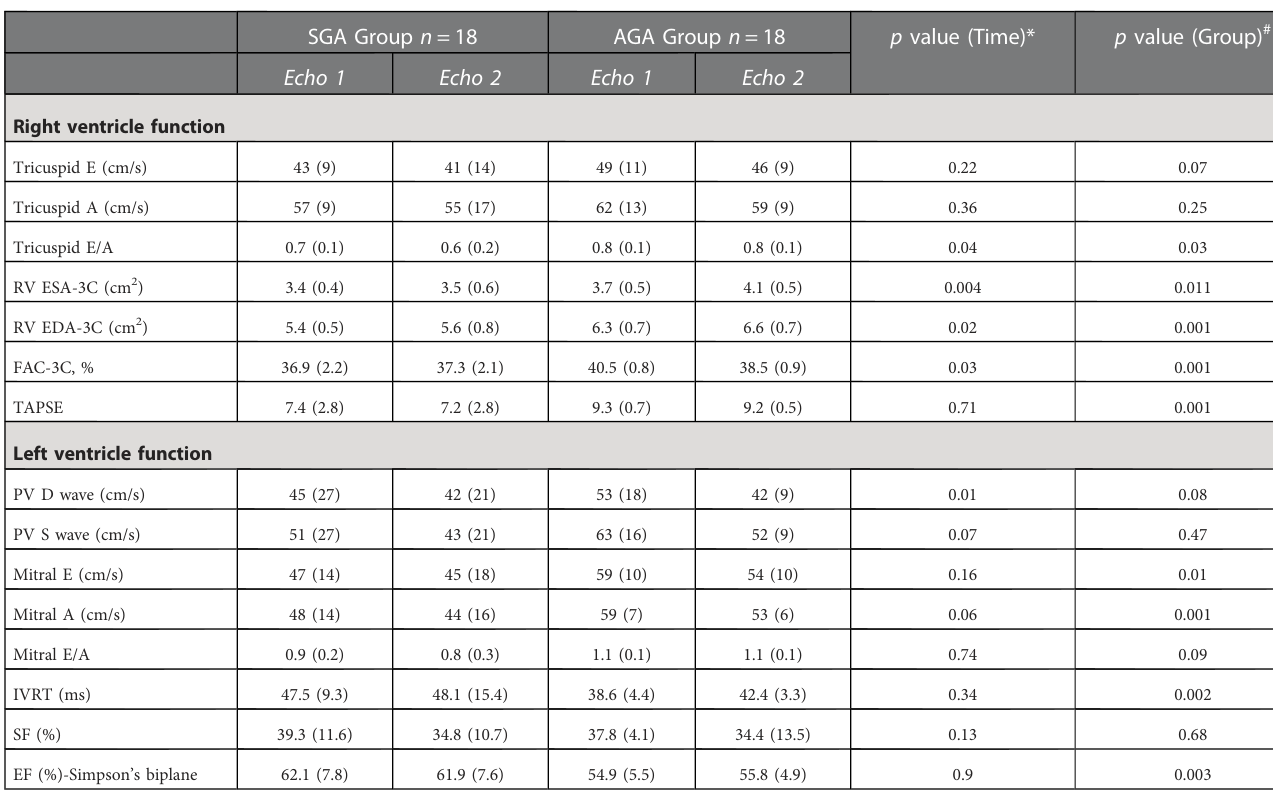
TABLE 3 Effect of group and time on ventricular function.